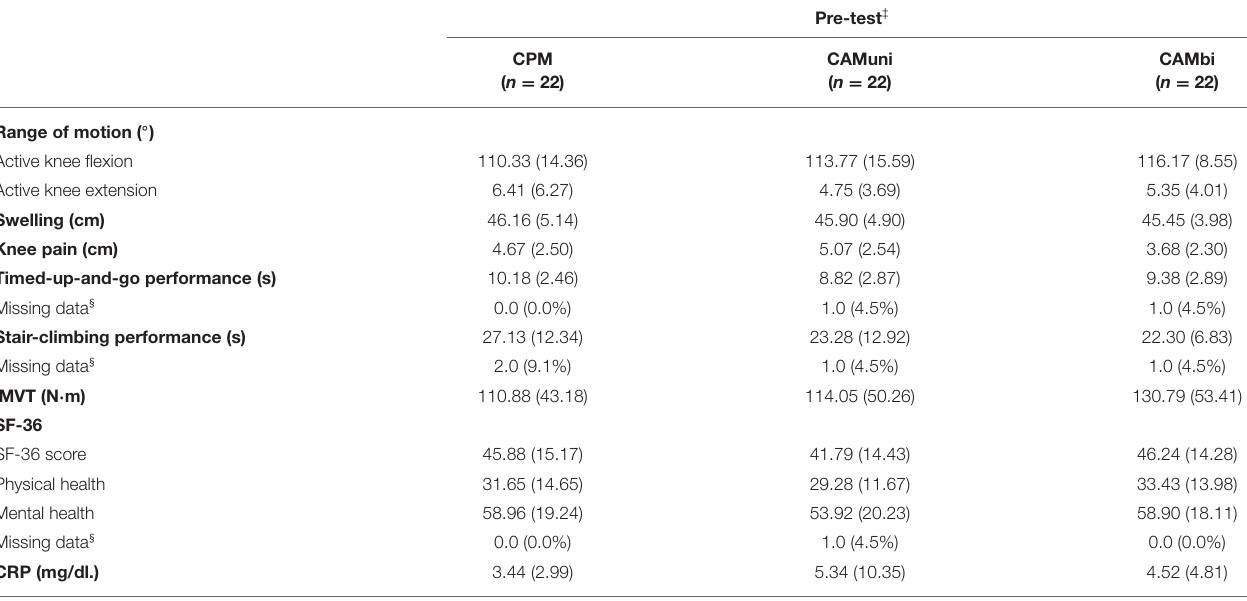
TABLE 2 | Measures of clinical, functional, and quality of life outcomes at pre-test (modified intention-to-treat